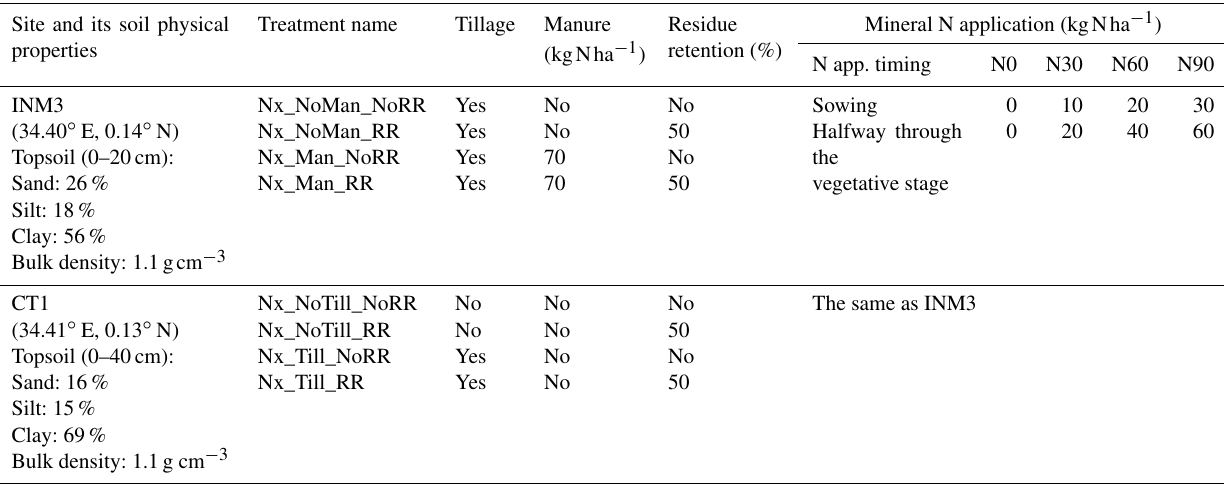
Table 2. Site- and treatment-specific data used for model evaluation at the INM3 and CT1 long-term (2003–2015) trials. The “x” in the treatment names denotes any mineral N application rate of 0, 30, 60, and 90kgNha − 1 . A total of 33% and 66% of the mineral N fertilizer are applied at the time of sowing and halfway through the vegetative stage, respectively, following the description in Sommer et al. (2018). Abbreviations: NoMan – no manure application; NoRR – no residue retention; NoTill – no-tillage; Man – 70kgNha − 1 of manure